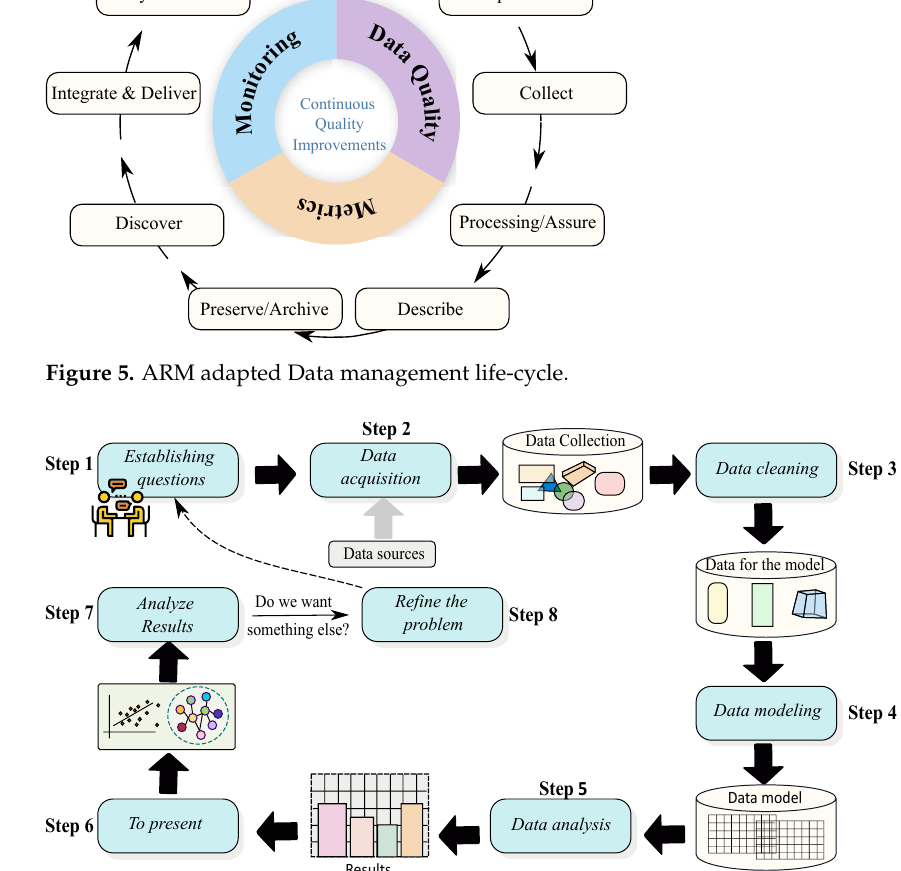
Figure 6. Analysis process for data science.